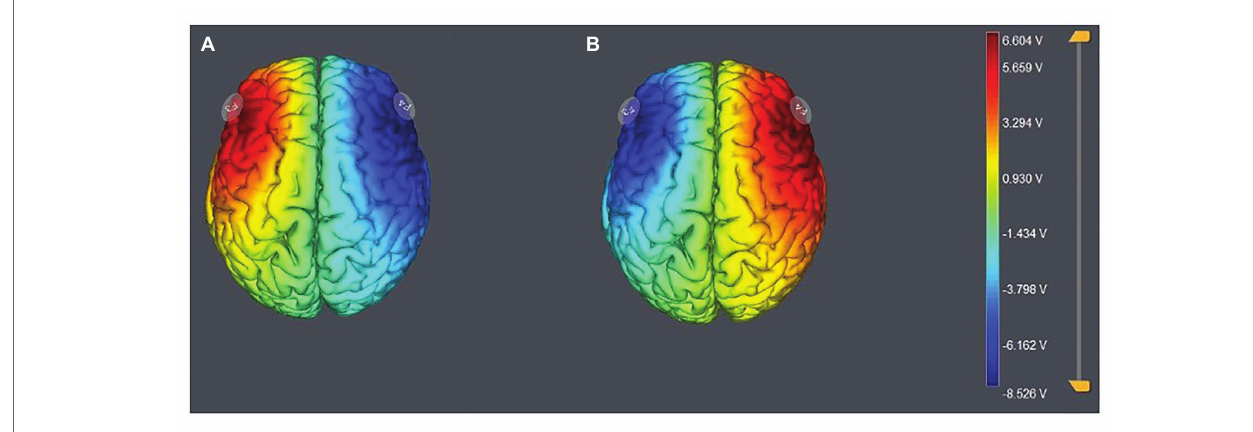
FIGURE 2 | Stimulation modes of the two treatments. Anodal stimulation over the left DLPFC and cathodal stimulation over the right DLFPC (A) and anodal stimulation over the right DLPFC and cathodal stimulation over the left DLFPC (B)